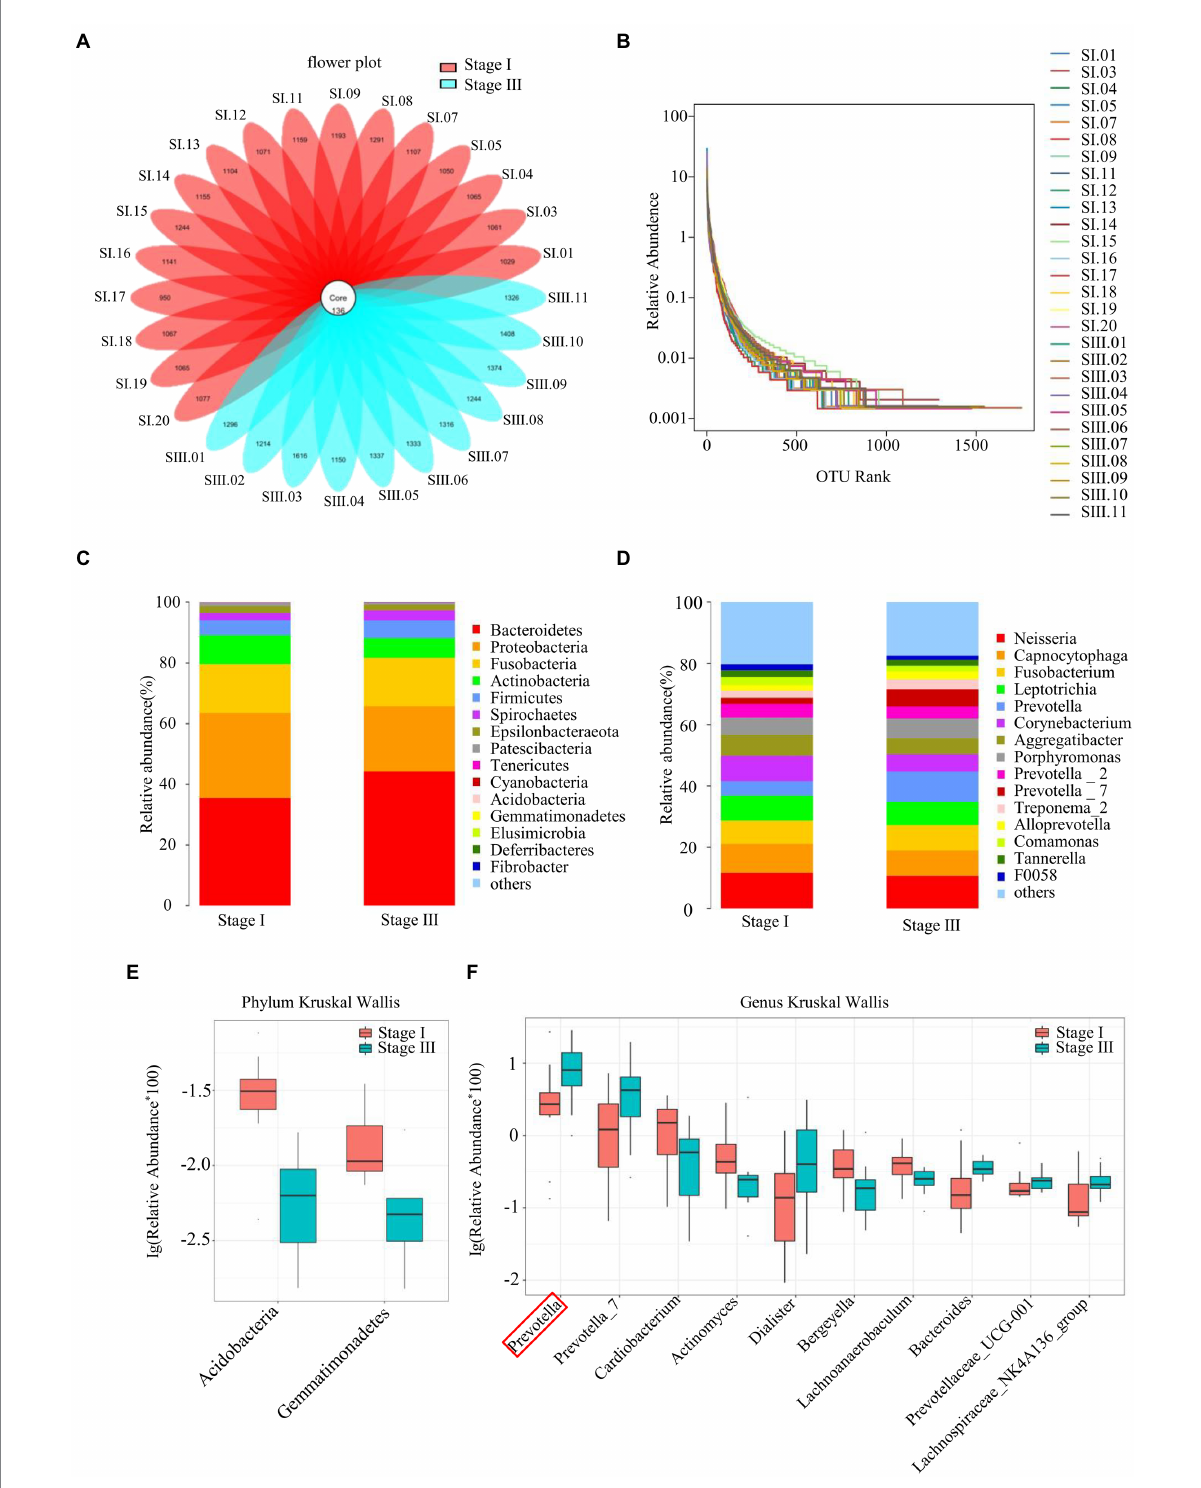
FIGURE 1 Sequence quality and composition of oral microbiomes. (A) A flower plot. (B) Rank–abundance curves for all samples. Comparison of the composition of oral microbiomes between stage I and stage III samples at the phylum (C) and genus (D) levels. Analysis of species differences between stage I and stage III samples by the Kruskal–Wallis test at the phylum (E) and genus (F)